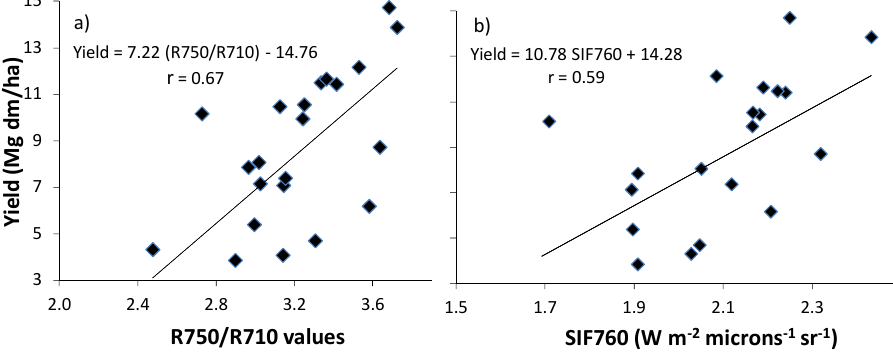
Figure 6. Maize yield vs. the R750/R710 values ( a ) and vs. the Normalized Difference Vegetation Index (NDVI) ( b ) obtained from hyperspectral airborne images at flowering in maize plots with different N rates.